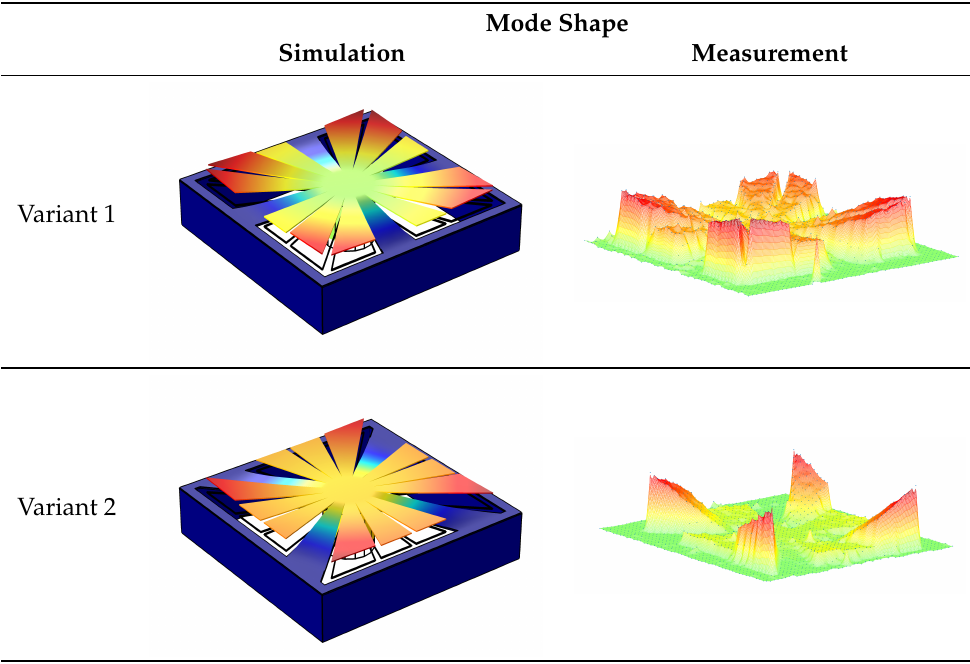
Table A1. Visualisation of the mode shape of the